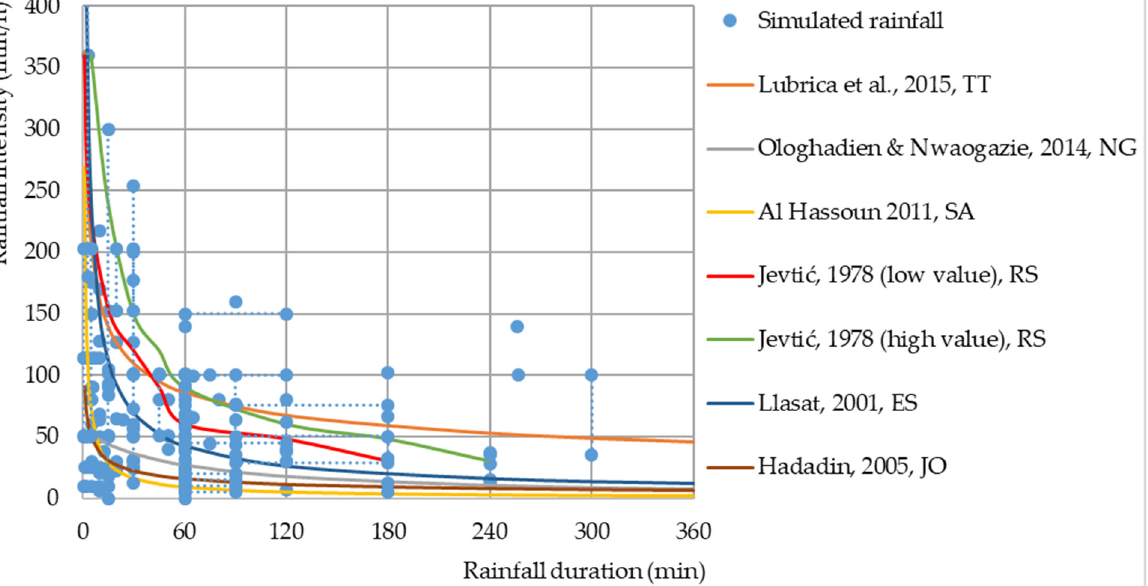
Figure 11. Rainfall intensity as a function of the duration of natural and simulated rainfalls. Note: two capital letters after reference represent the ISO Alpha-2 country code that designates countries in which measurements have been conducted [23,129–133]. Note: dotted lines represent simulated rainfall duration and rainfall intensity values that are given in a range.